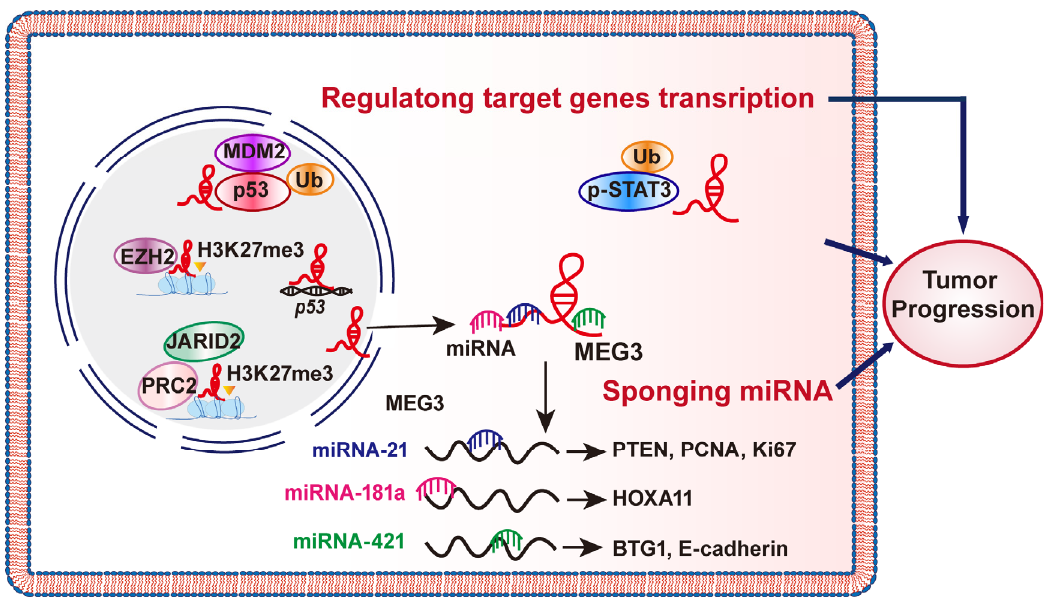
Figure 2. MEG3 inhibits cancer progression through different mechanisms. MEG3 is involved in tumor progression in two ways, such as acting as a sponge for miRNA and regulating its targets through transcriptional as well as post-translational